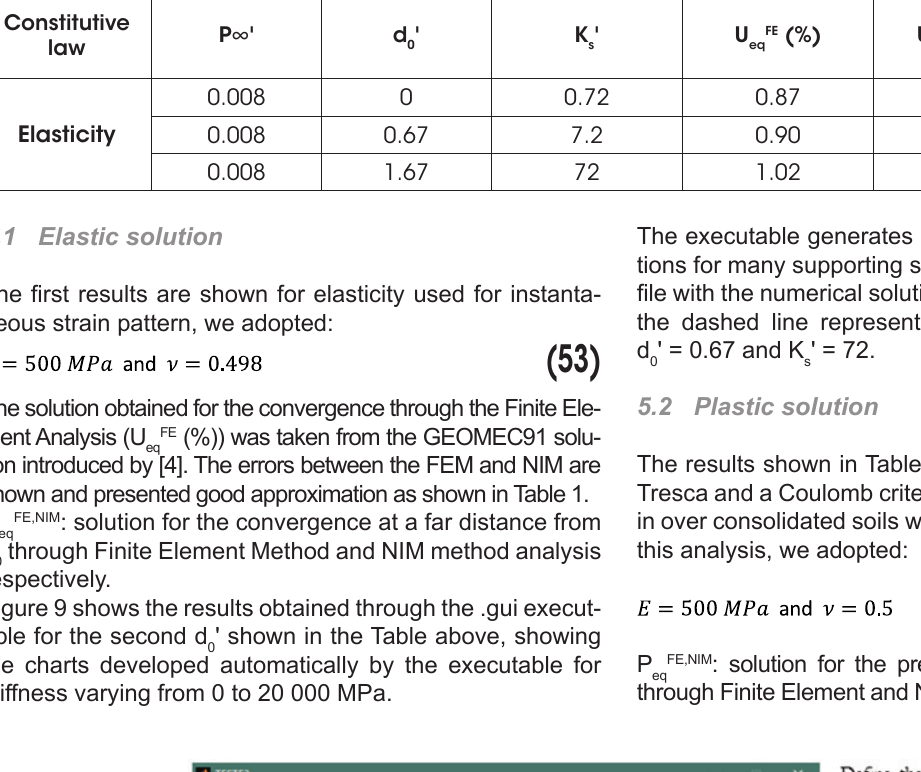
Validity of the method for elastic rockmass Constitutive law